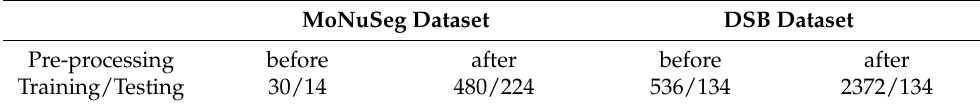
Table 1. The quantity of training and testing images changed pre and post the preprocessing